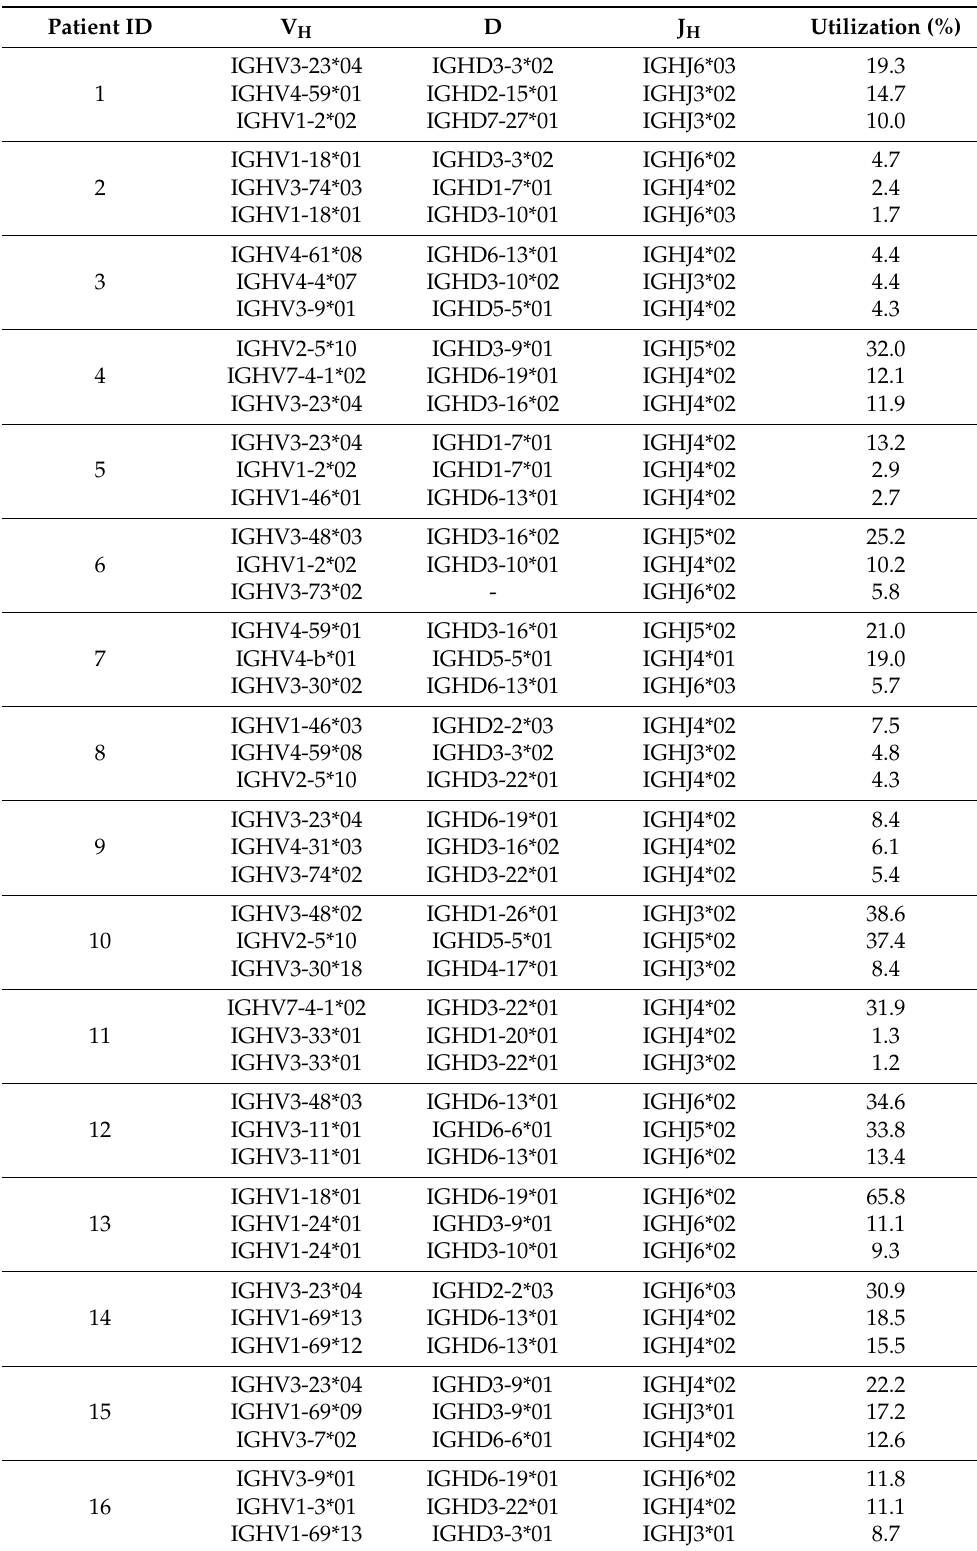
Table 2. The top three V H DJ H patterns used by AML